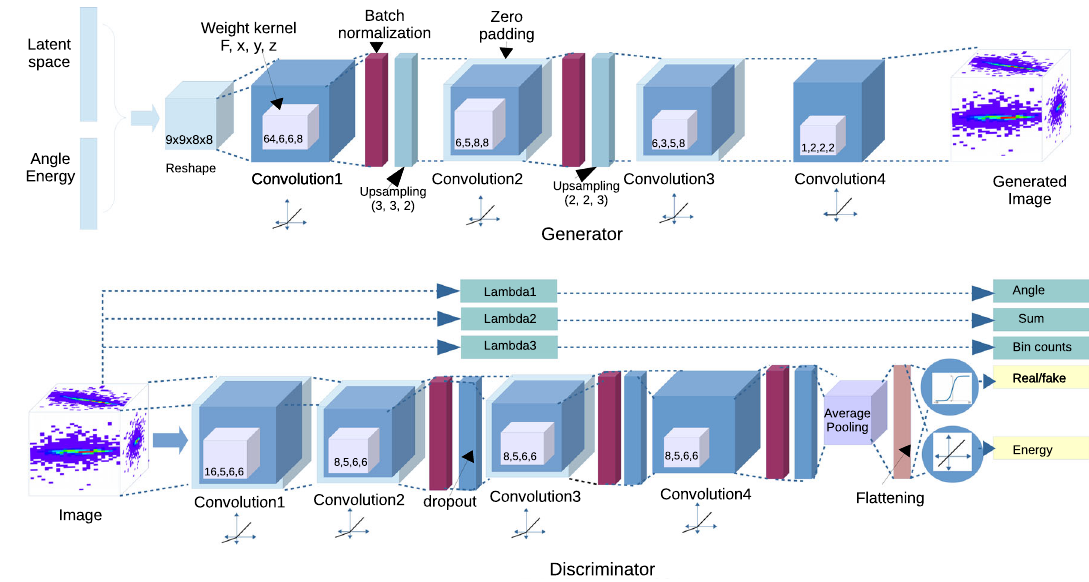
Fig. 6 3DGAN generator and discriminator network